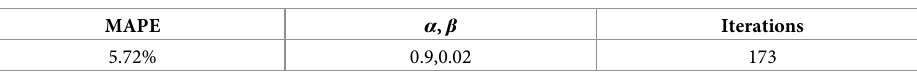
Table 2. Iterative